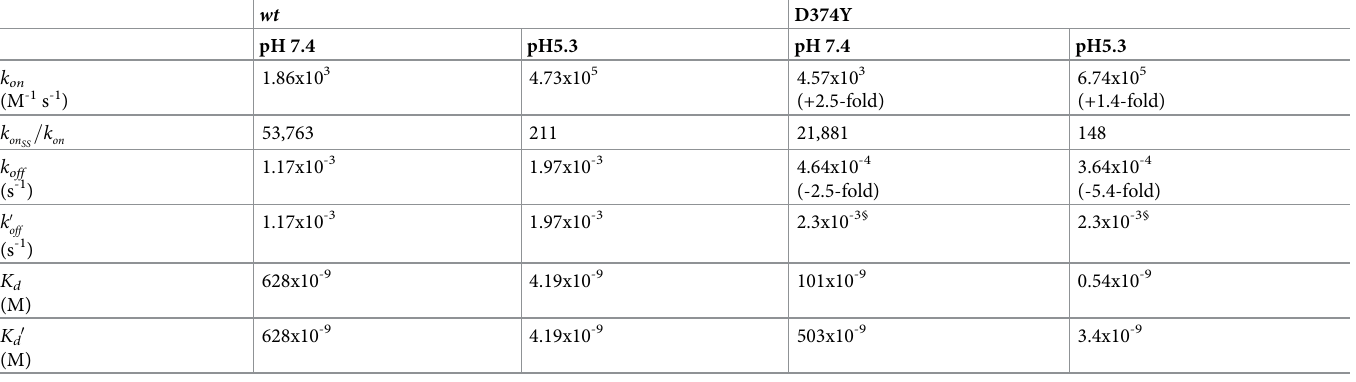
Table 2. Measured binding kinetics data for wt and D374Y mutant PCSK9- LDL-R [12]. Fold differences between k on and k off for D374Y versus wt are shown in paren- thesis, noting that the t 1/2 of the bound complex is similar to that of wt PCSK9, but considerably longer than that of the D374Y mutant (which is likely subject to k off hijack- ing). The ratio of k = k was calculated based on k = 1x10 8 M -1 s -1 , corresponding to k on SS on on SS